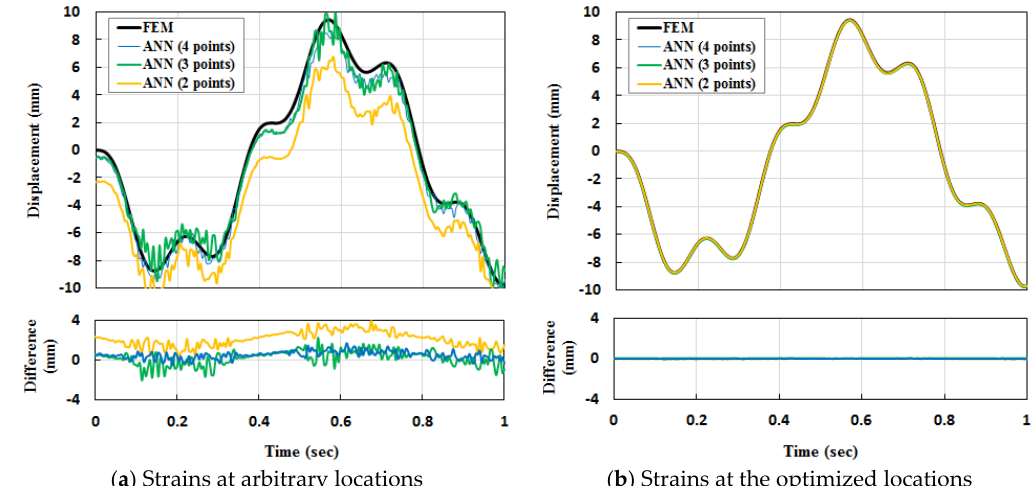
Figure 7. Displacements over time at the beam center for test dataset.